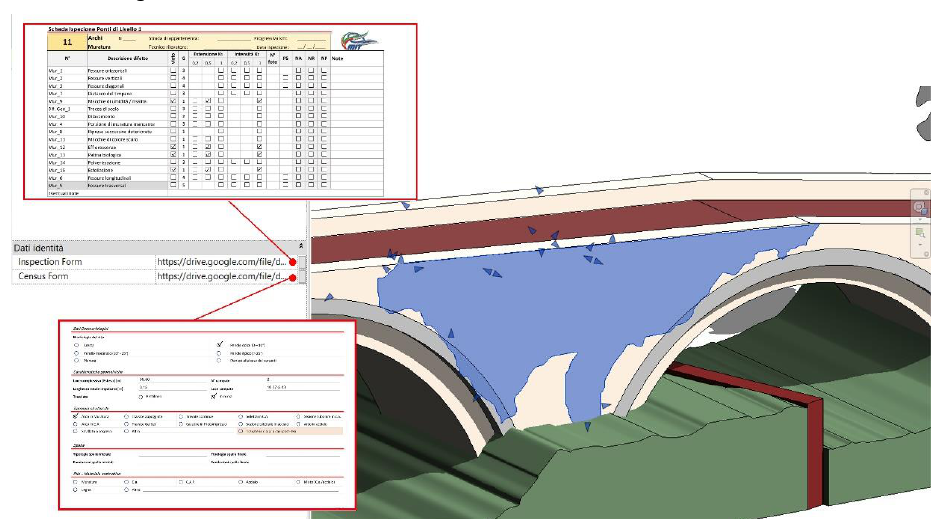
Figure 9 . Model correlation to forms shared in a storage